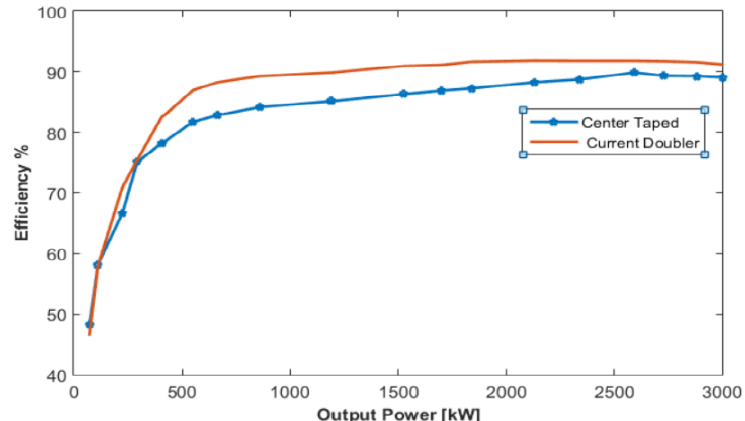
Figure 16. Comparisons of power conversion efficiency.